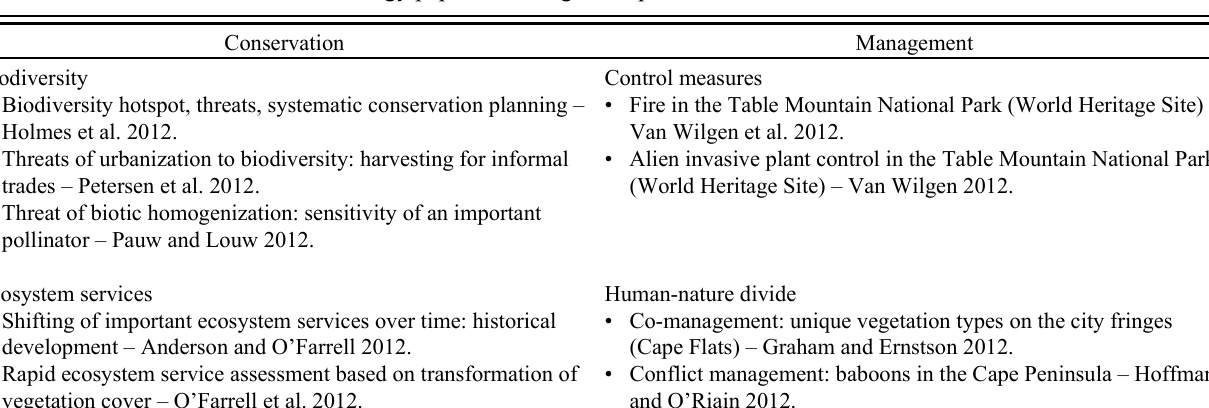
Table 1 . Main themes of the urban ecology papers focusing on Cape